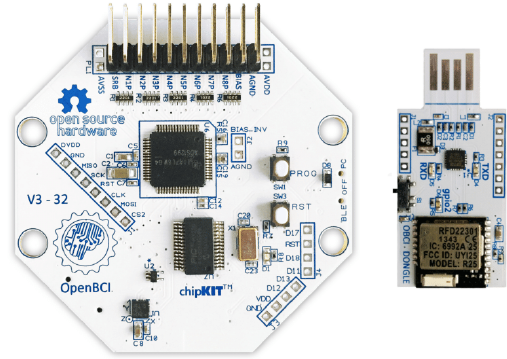
Figure 1. OpenBCI Cyton board and dongle.